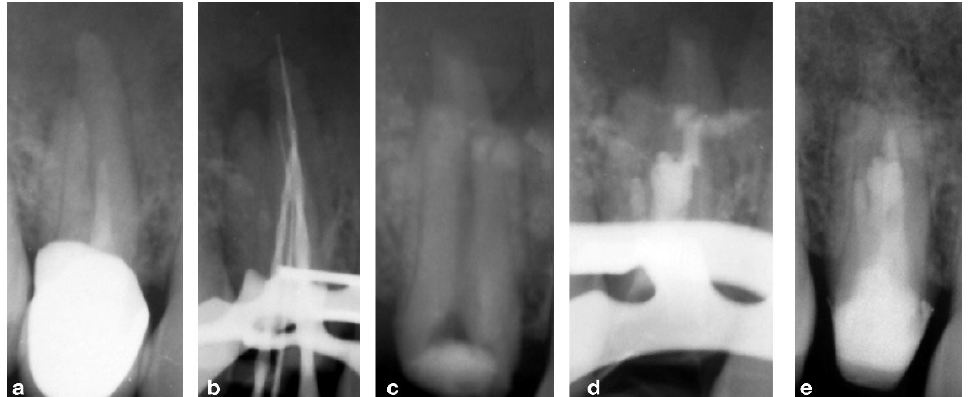
Figure 2. ( a ) Pre ‐ operative X ‐ rays showing the complex anatomy, ( b ) intra ‐ operative X ‐ ray with endodontic instruments to better understand the anatomy, ( c ) post ‐ operative view of the endodontic surgery, ( d ) orthograde filling with gutta ‐ percha, ( e ) 1 ‐ year follow ‐ up.